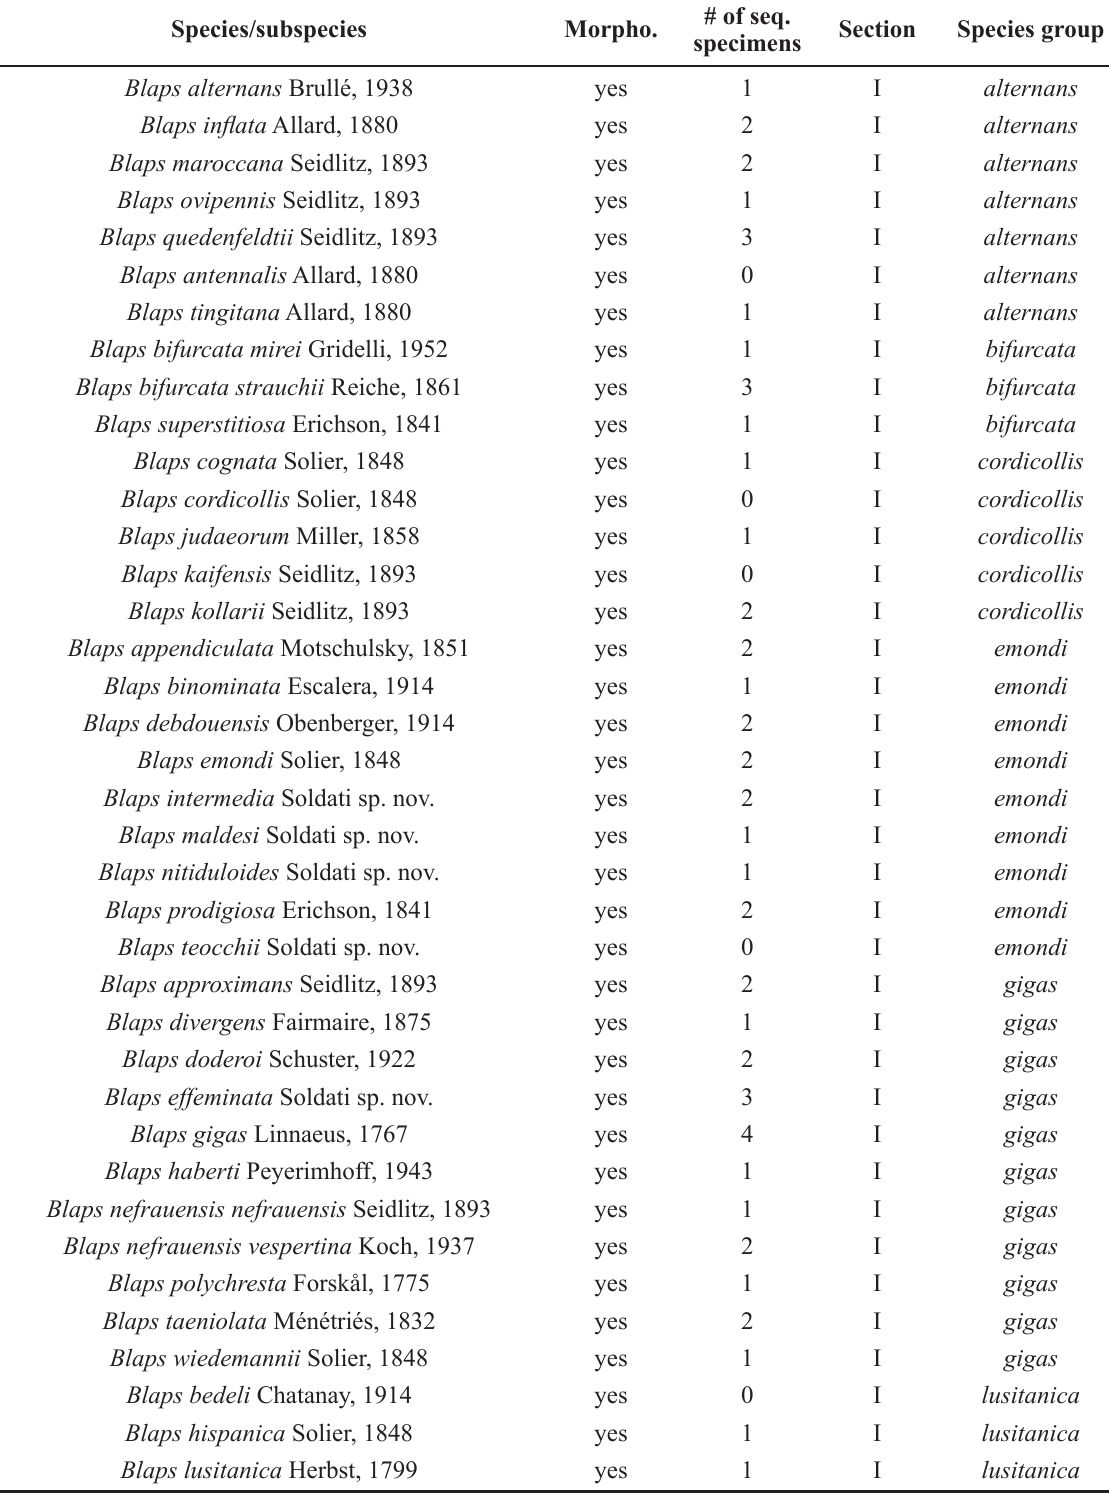
Table 1. Taxon sampling. For each species and subspecies, the avialability of morphological data (the 'Morpho.' column) and the number of sequenced specimens are indicated. Additional taxonomic information for species of Blaps is also provided (section and species group for members of section I). [continued on next page] # of seq. Species/subspecies Morpho. Section Species specimens